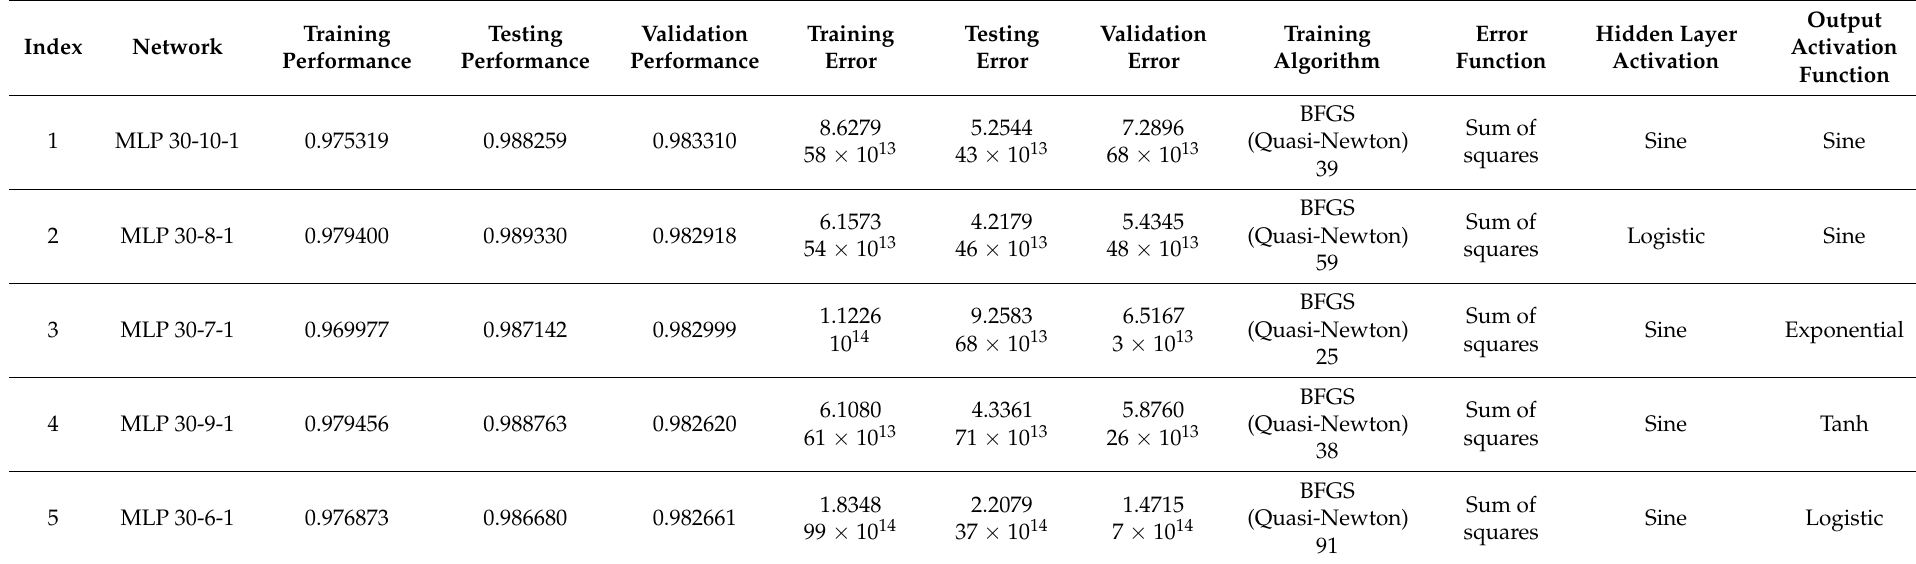
Table 6. Retained neural networks from Experiment